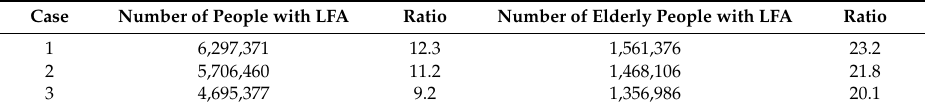
Table 4. Number of the people with LFA in Korea.